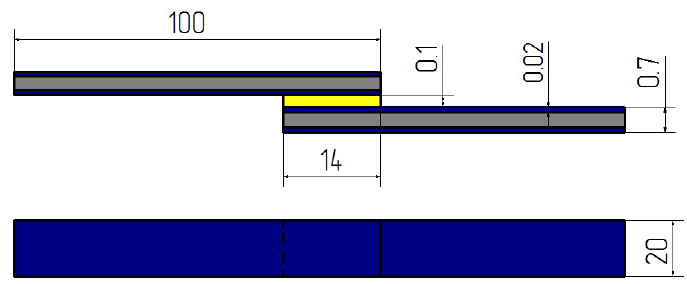
Figure 1. Shape and dimensions of a single-lap adhesive joint of hot-dip galvanized steel sheets.